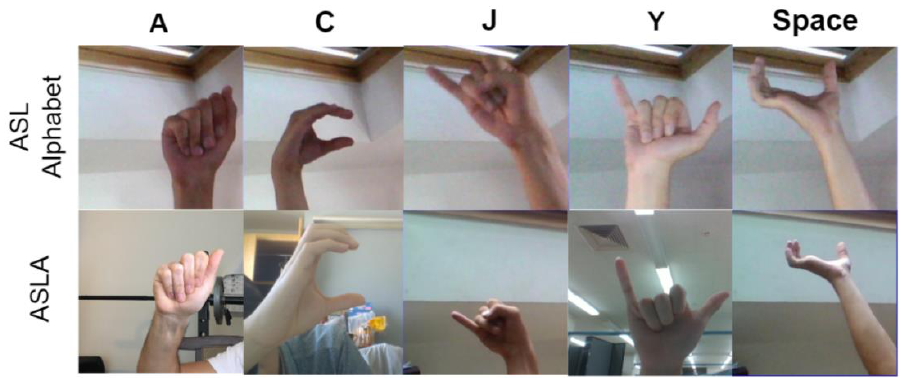
Figure 1. Sample images from the ASL Alphabet and ASLA